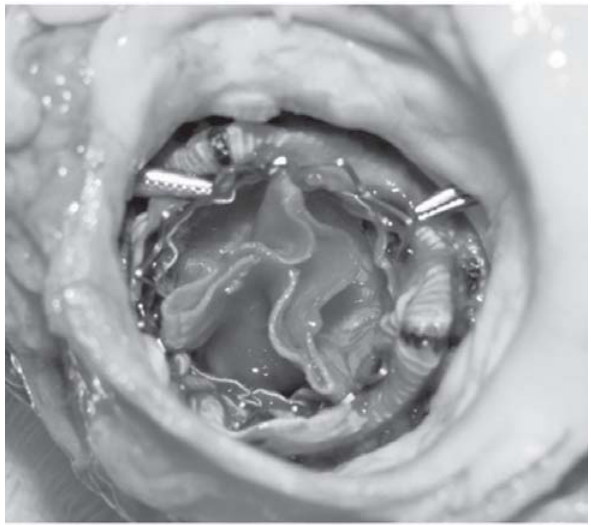
Fig. 4 – Achado necroscópico com boa aposição entre as próteses e os folhetos preservados. Óstios coronarianos livre (identificados por pinças